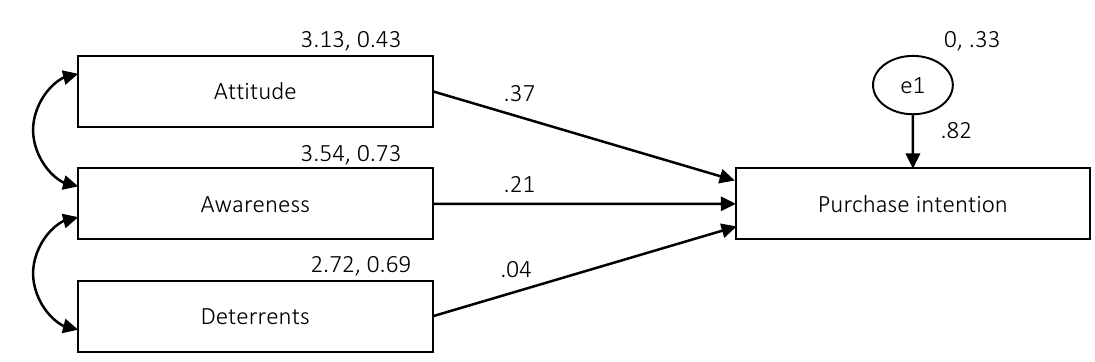
Figure 3. Confirmatory factor analysis